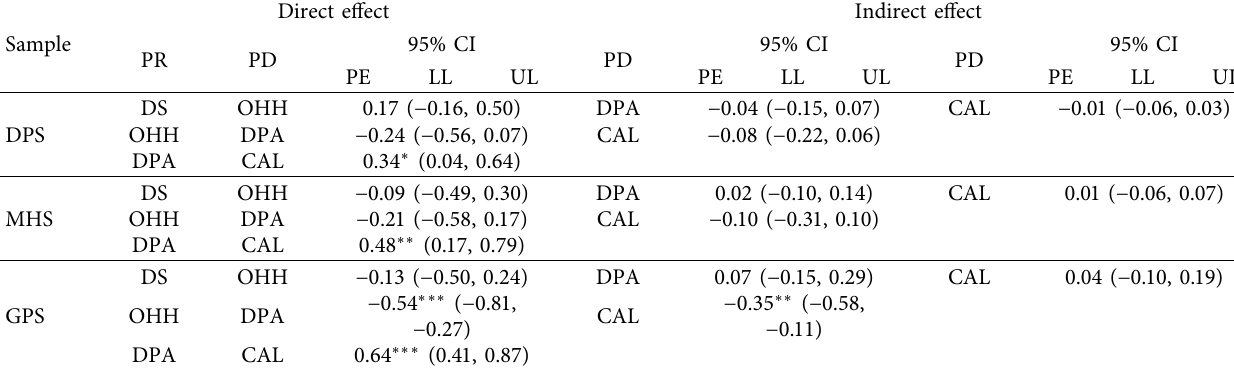
Table 6: Standardized direct and indirect